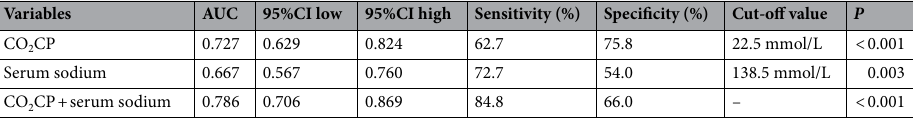
Table 1. ROC curves analysis for all-cause death in ATAAD.